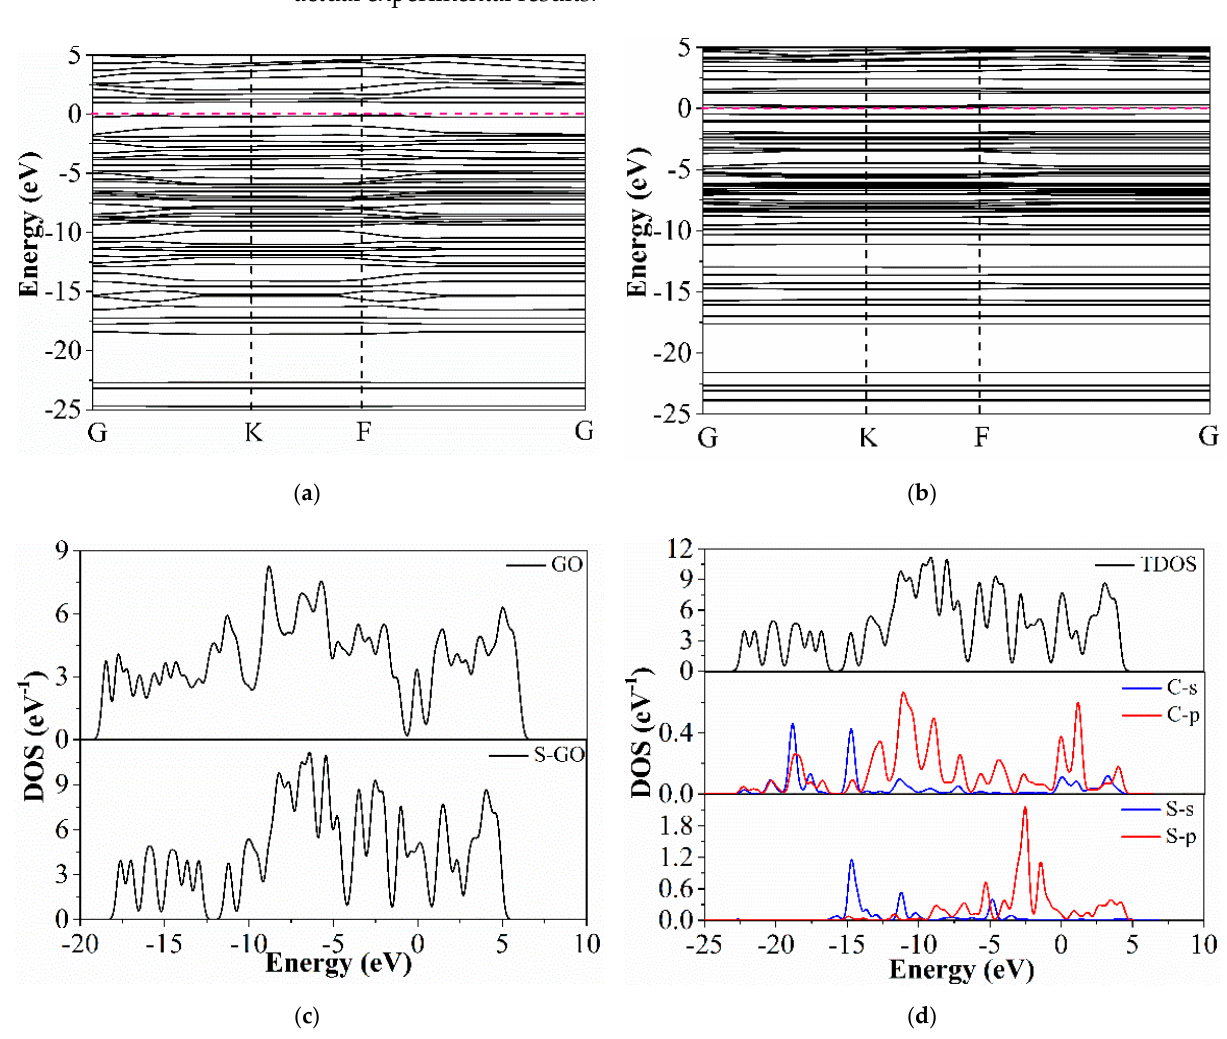
Figure 10. Band structure diagram of ( a ) GO and ( b ) S-GO; ( c ) DOS diagrams of GO and S-GO; ( d ) TDOS diagram of S-GO.